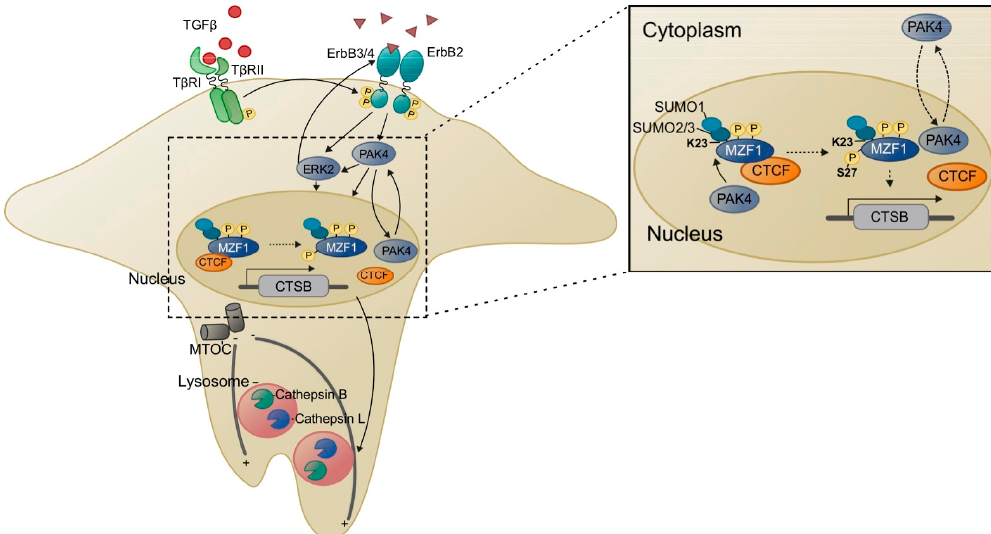
Figure 3. Graphical presentation of MZF1 activation and induction of CTSB expression in lysosome- mediated invasion as a response to ErbB2 signaling. ErbB2 activation, further supported by